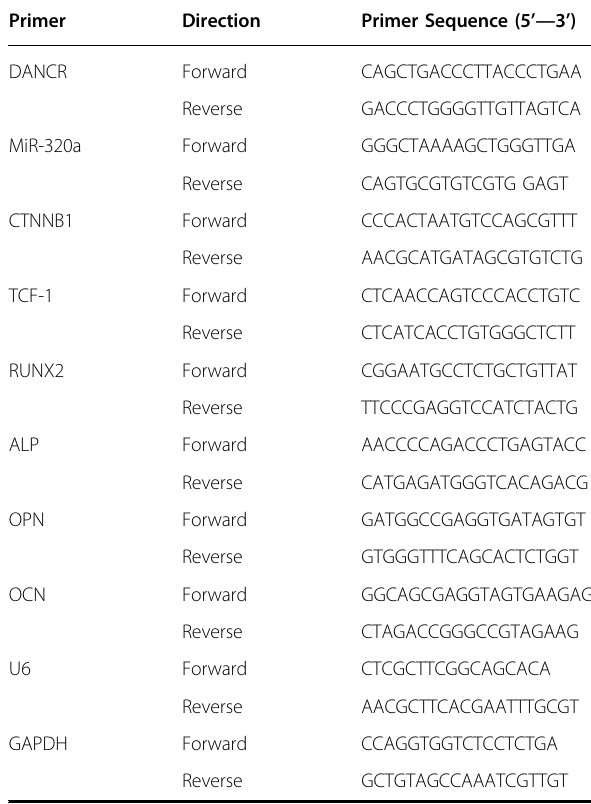
Table 1 Primers used for